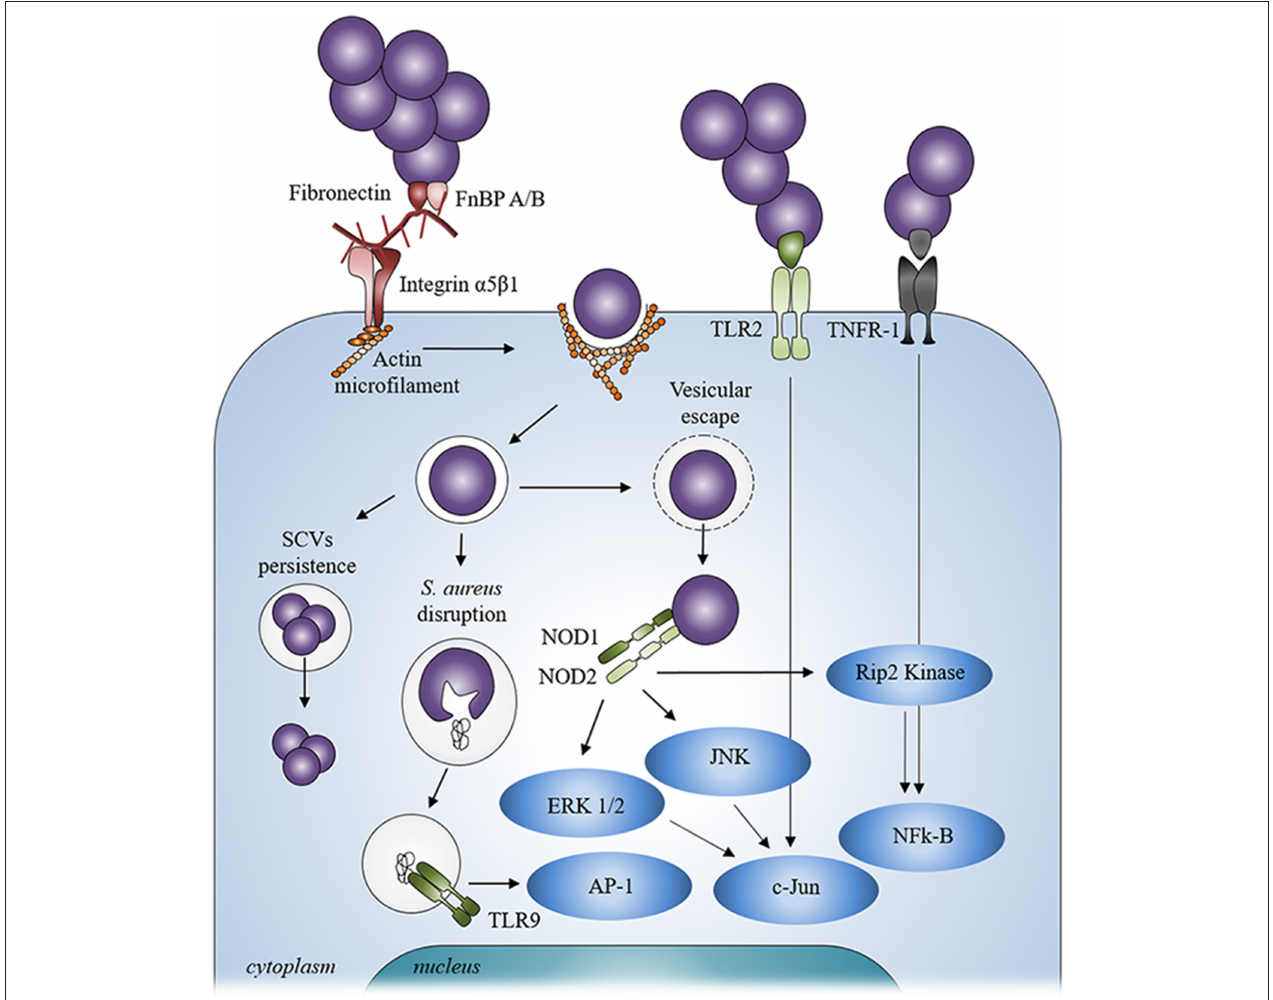
FIGURE 2 | Staphylococcus aureus signaling mechanism after contact and internalization by osteoblasts. After internalization, Staphylococcus aureus can escape from vesicle, be disrupted from inside the vesicle or persist inside osteoblasts through a SCV phenotype. Staphylococcus aureus can also interact with extracellular receptors TLR2 and TNFR-1 and with intracellular receptors TLR9 and NODs after its internalization into osteoblasts thanks to α 5 β 1 integrin and actin filaments.